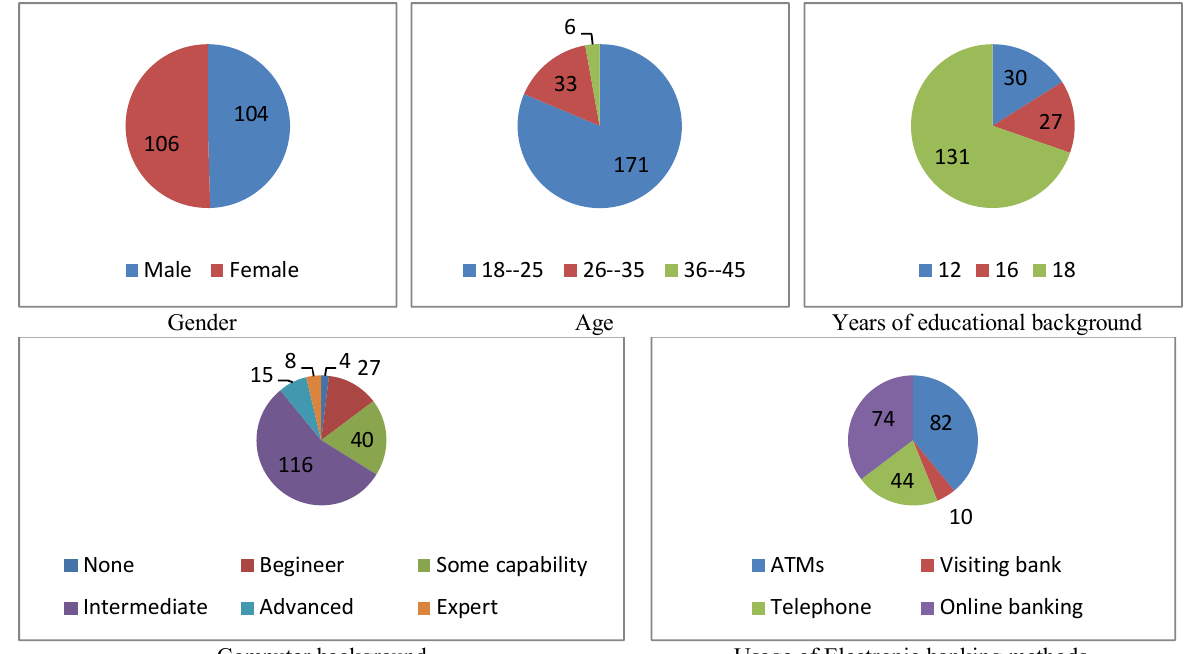
Fig. 3. Personal characteristics of online bank